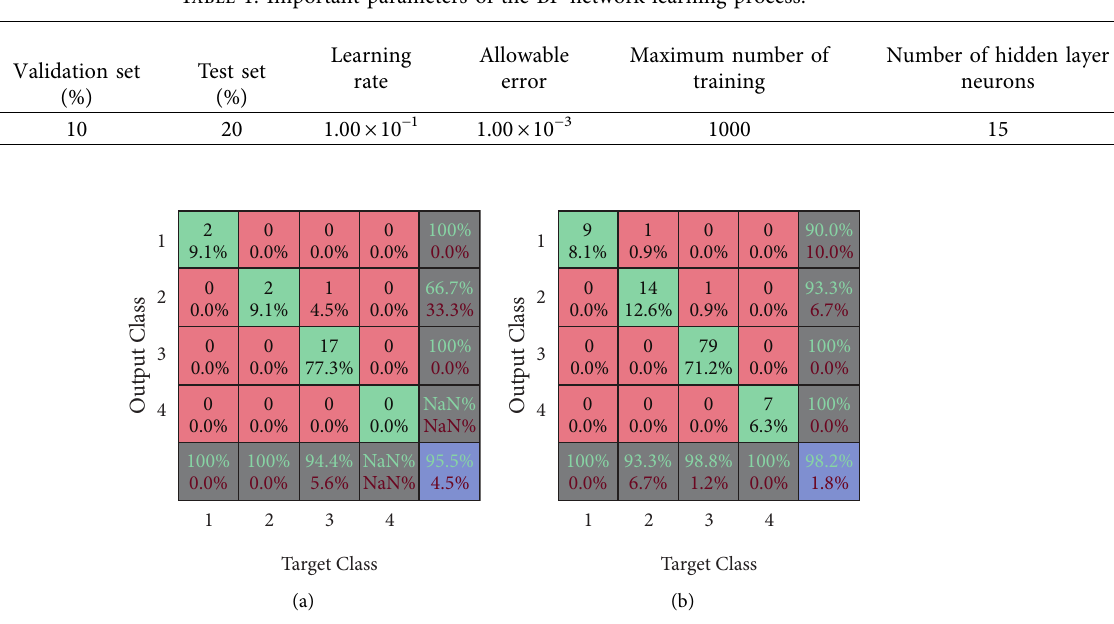
Figure 5: Confusion matrix analysis diagram of classification model prediction results. (a) Test set. (b) Overall set.